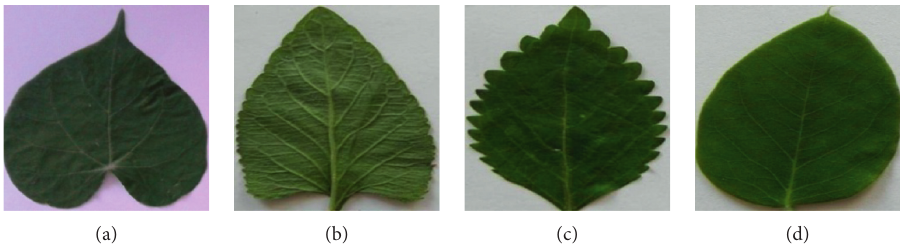
Figure 1: Sample images in database.